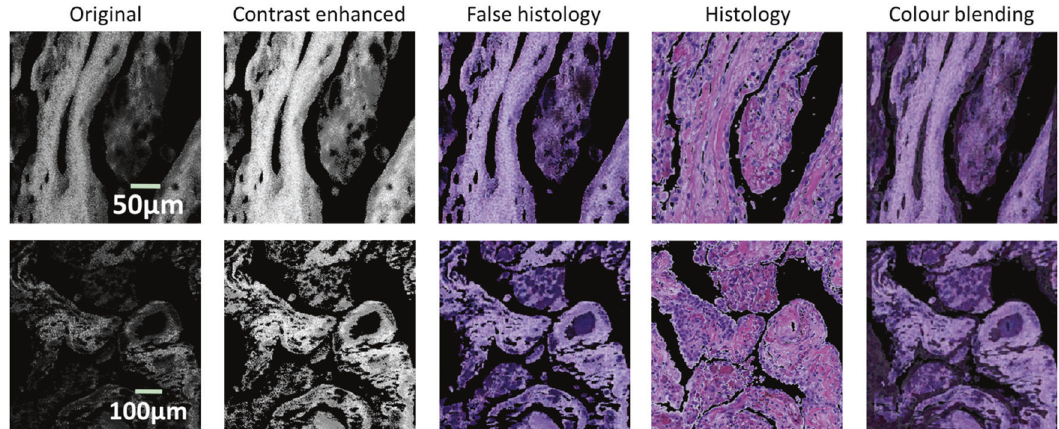
Fig. 3 Example of the registration with lifetime images in greyscale. The images in the fi rst row correspond to the ones in Fig. 2. The original greyscale lifetime images ( fi rst column) need to be contrast-enhanced (second column) so that the generated false histology images (third column) and the corresponding histology patch (fourth column) can be reasonably registered ( fi fth column).